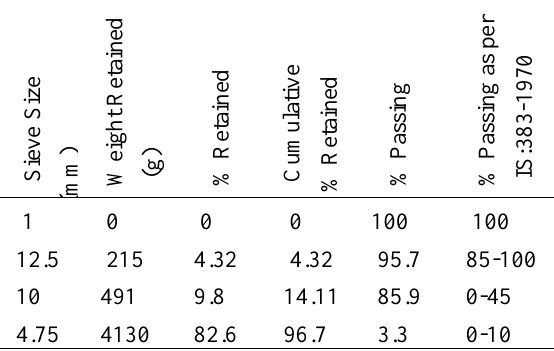
Sieve analysis of coarse aggregate (12.5 mm down)